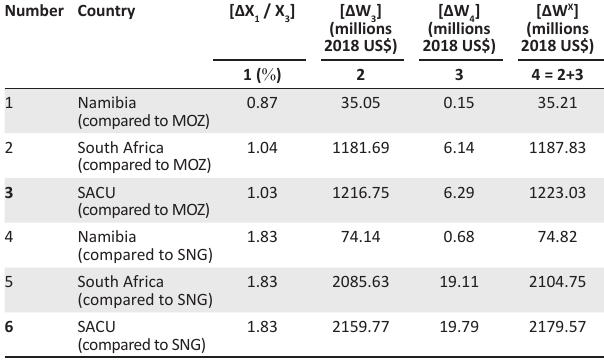
TABLE 6: Economic effects of excess compliance cost to export.